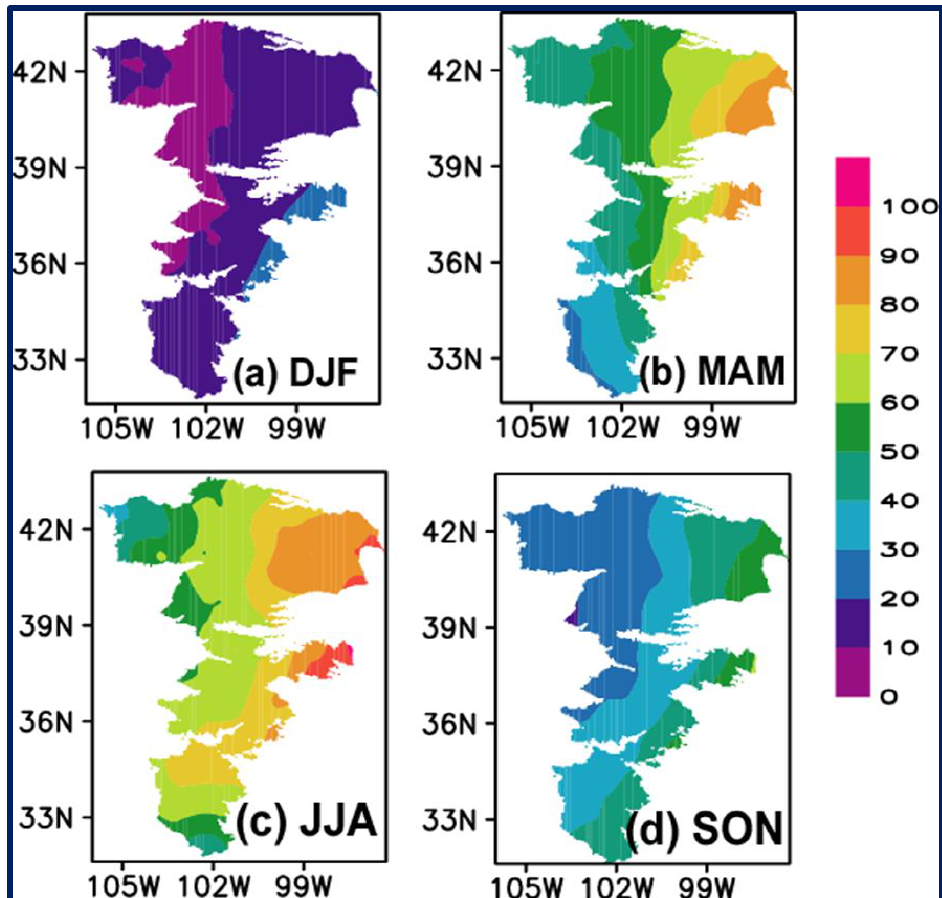
Figure 4. Observed seasonal mean precipitation (mm/month) over the Ogallala Aquifer region dur-